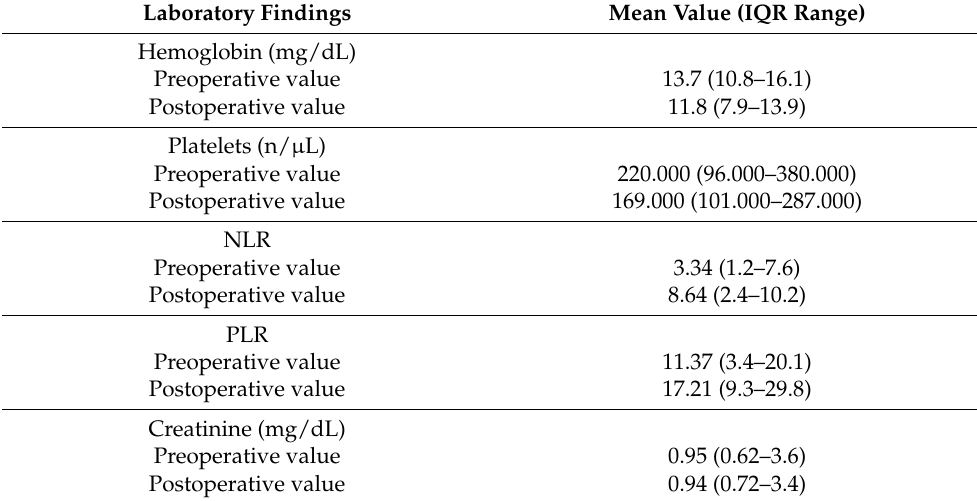
Table 2. Laboratory results in patients that underwent elective